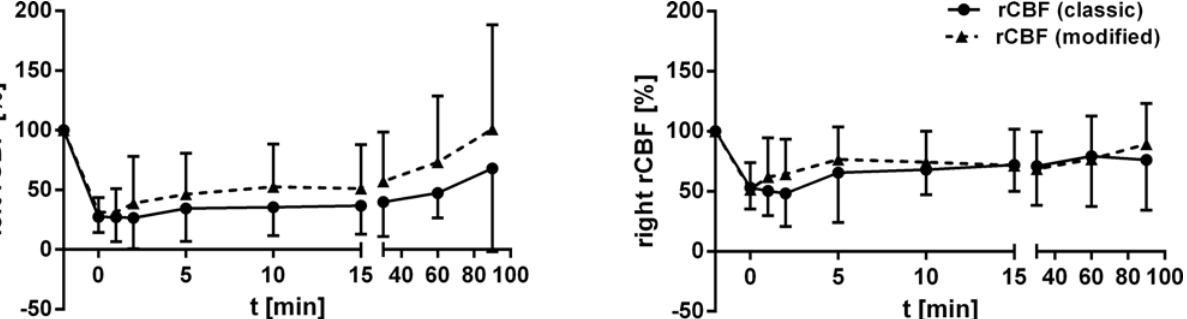
Fig 3. Course of left and right rCBF. Graphs showing percentage changes (mean +/- standard deviation) of left and right rCBF (percentage of baseline).